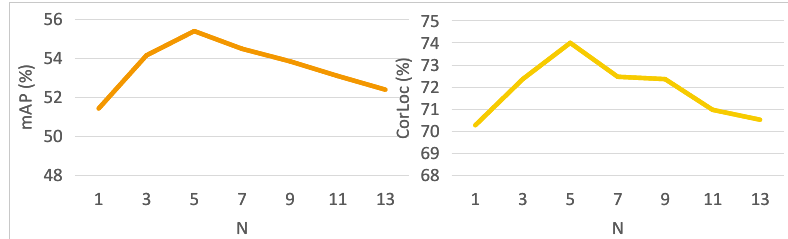
Figure 3. The effect of number of vectors N.